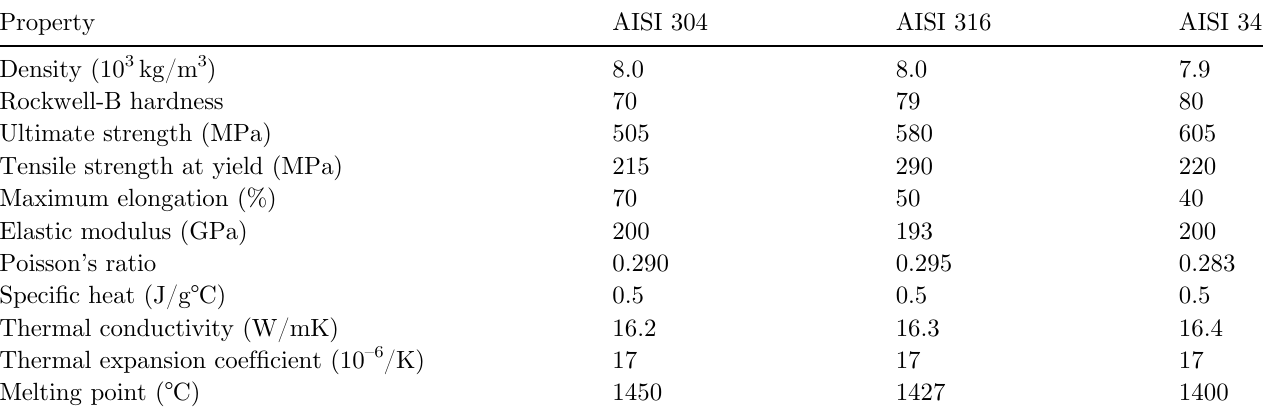
Table 1. Austenitic stainless steel series 300 properties at room temperature [7 –